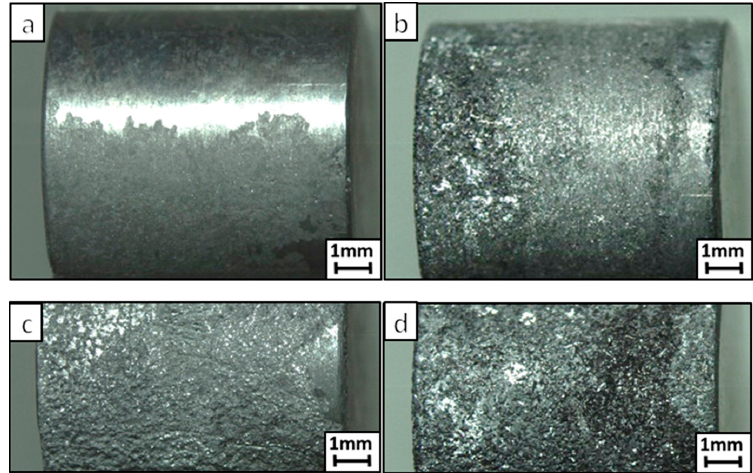
Figure 4. Optical microscopy showing corrosion attack at the surface of pure Zn and Zn–1.3Fe alloy after immersion tests in phosphate-buffered saline (PBS) solution at 37 °C. ( a , b ) pure Zn and Zn–1.3Fe alloy after 10 days of exposure. ( c , d ) pure Zn and Zn–1.3Fe alloy after 20 days of exposure.